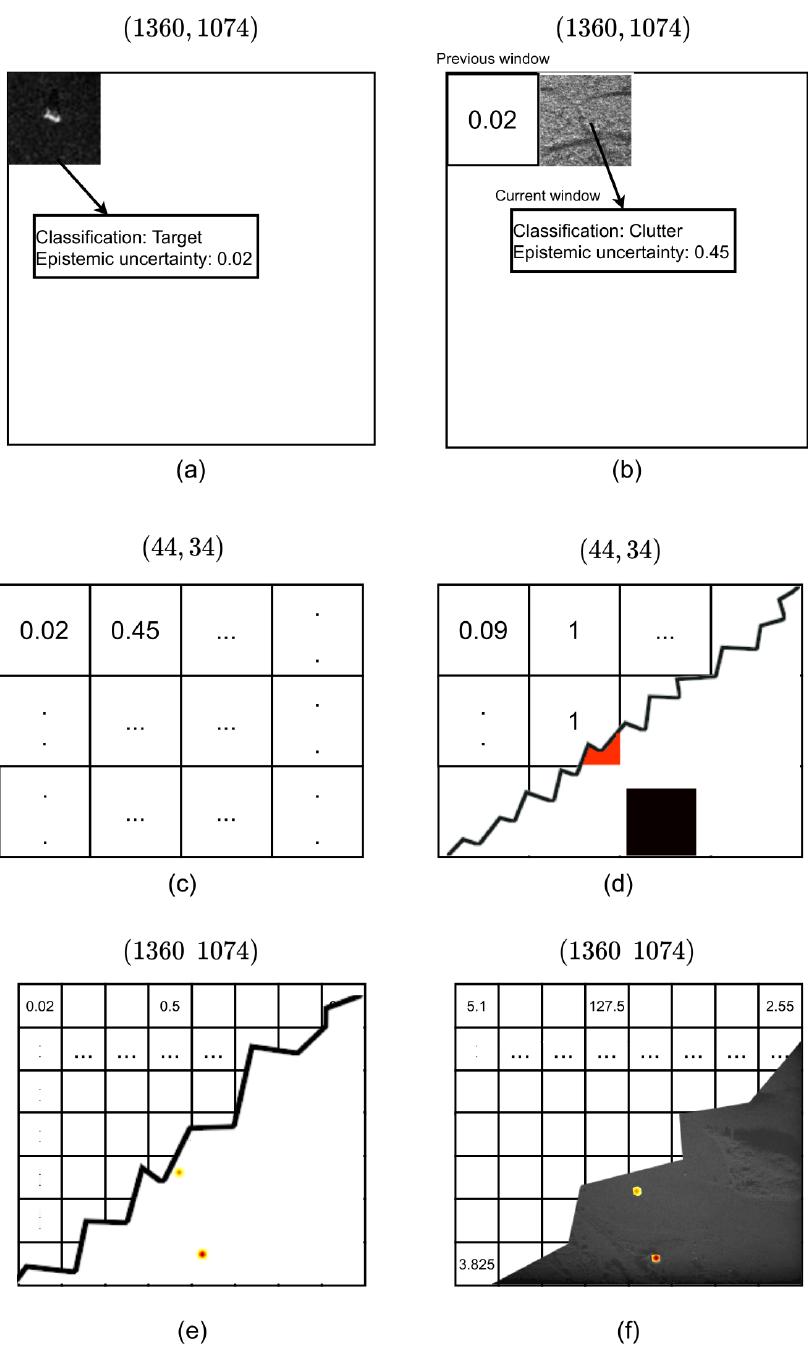
Figure 4. Illustration of the method to produce uncertainty heat maps. ( a ) Each window is passed through the classifier and the classification results and epistemic uncertainty is captured. ( b ) Shows the uncertainty value of the previous window, as well as the current classifier output and uncertainty value. ( c ) Shows all uncertainty values for the SAR scene, which is the base of the uncer- tainty heat map. ( d ) The uncertainty heat map is normalised. ( e ) The heat map is passed through an interpolation function. ( f ) The interpolated heat map is scaled to a maximum value of 255. Note that in ( d – f ) the plot has been split to show the numerical values in the matrix in the upper half and an example of the corresponding heat map or image in the lower